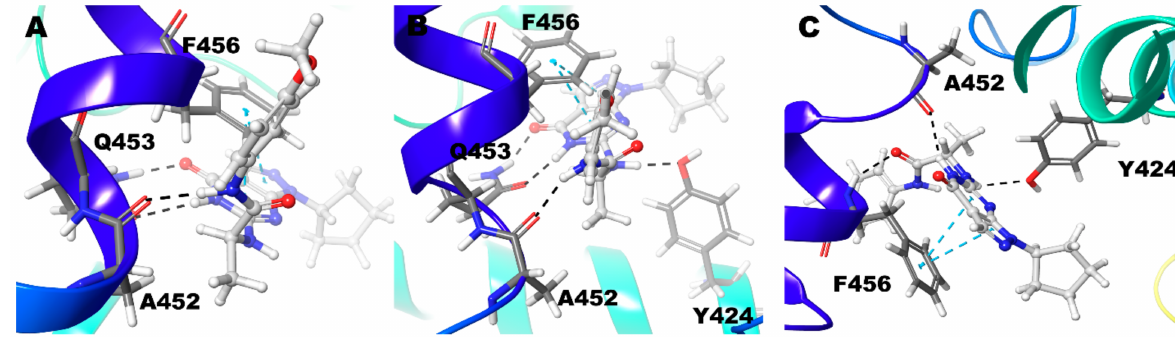
Figure 8. Non-bonded interactions of Compound 3 ( S ) in ( A ) PDE9 Zn/Mg ( B ) PDE9 Mg/Mg ( C ) PDE9